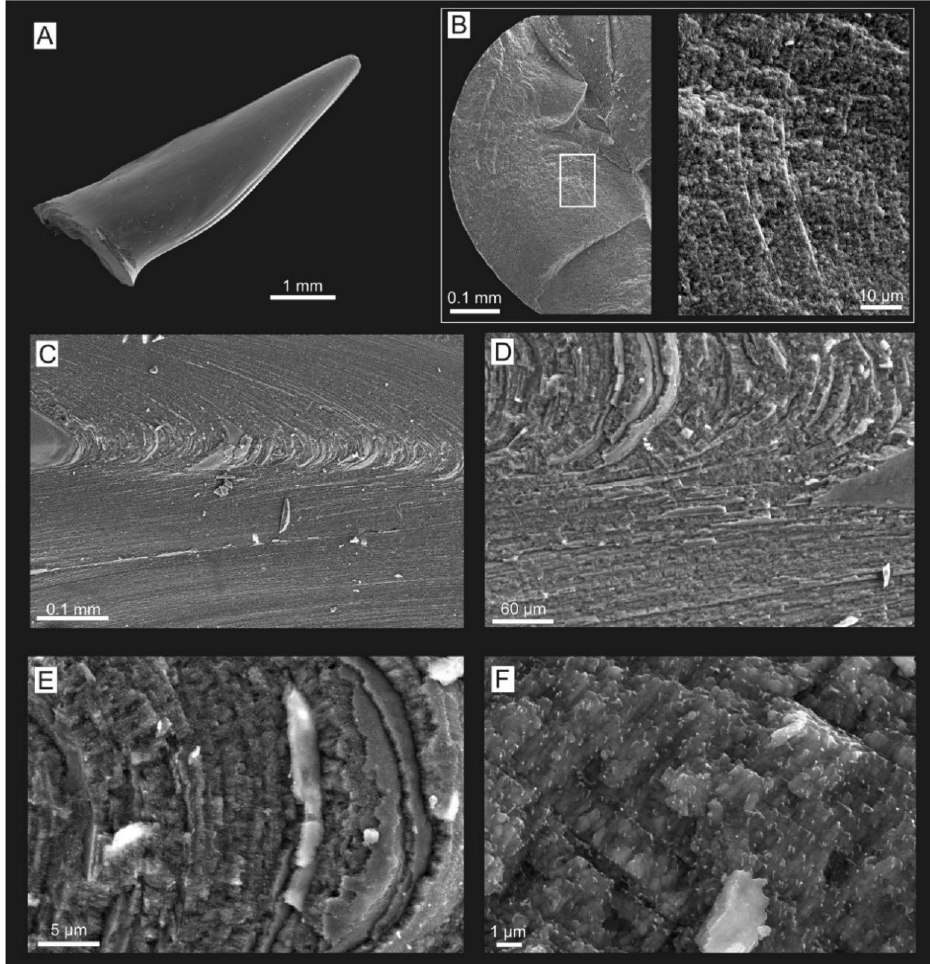
Figure 13. SEM images of the prong or spine of Sepia orbignyana . ( A ) General view of the prong (specimen SP-11). ( B ) Transversal section of the prong displaying fibrous and radial aragonite crystals distributed in concentric laminae (SP-12). ( C – E ) Longitudinal section (SP-14) showing the concentric laminae, which is parallel to the prong surface, and has the maximum curvature along the apical area ( C – E ). ( E ) Detailed image of ( D ), showing the concentric layering with and alternation of relatively thick aragonite-rich layers, and relatively very thin organic-layers. ( F ) Detail of the aragonite crystals displaying rod-like appearance and containing short organic fibers among them.